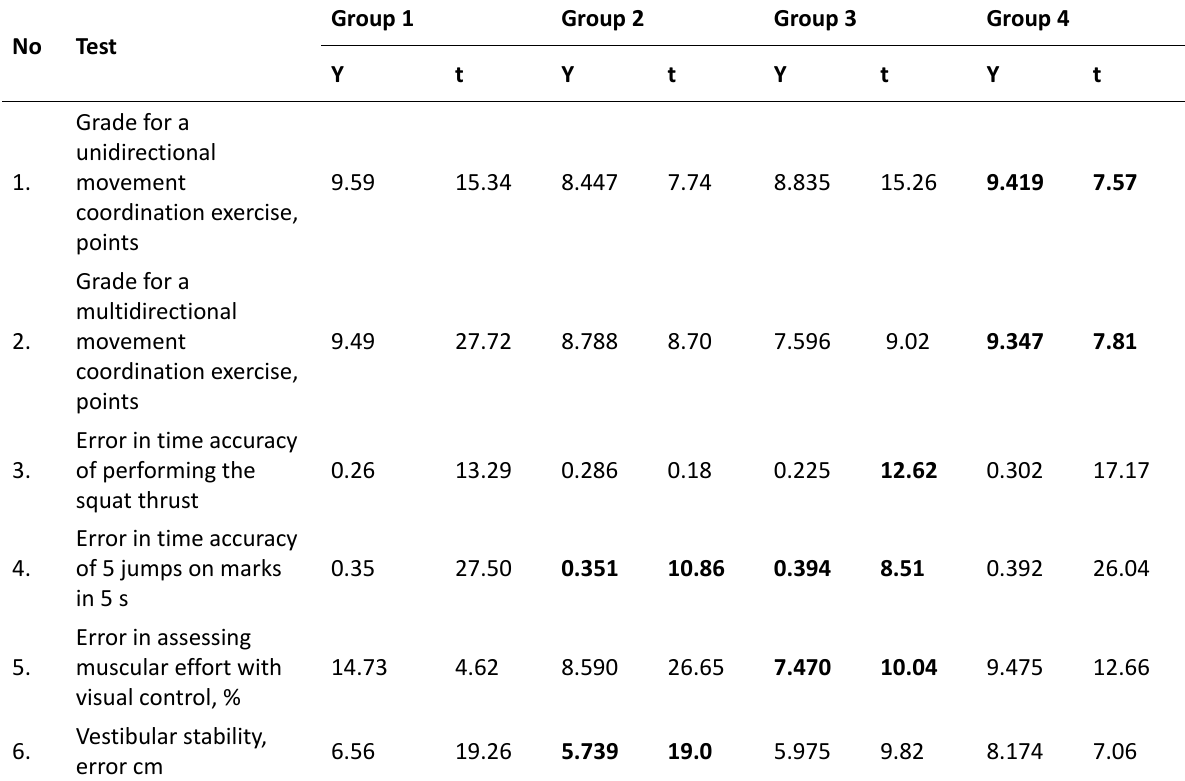
Table 3. Results of the logistic function analysis. Optimal result (Y) and time of its achievement (t, months)